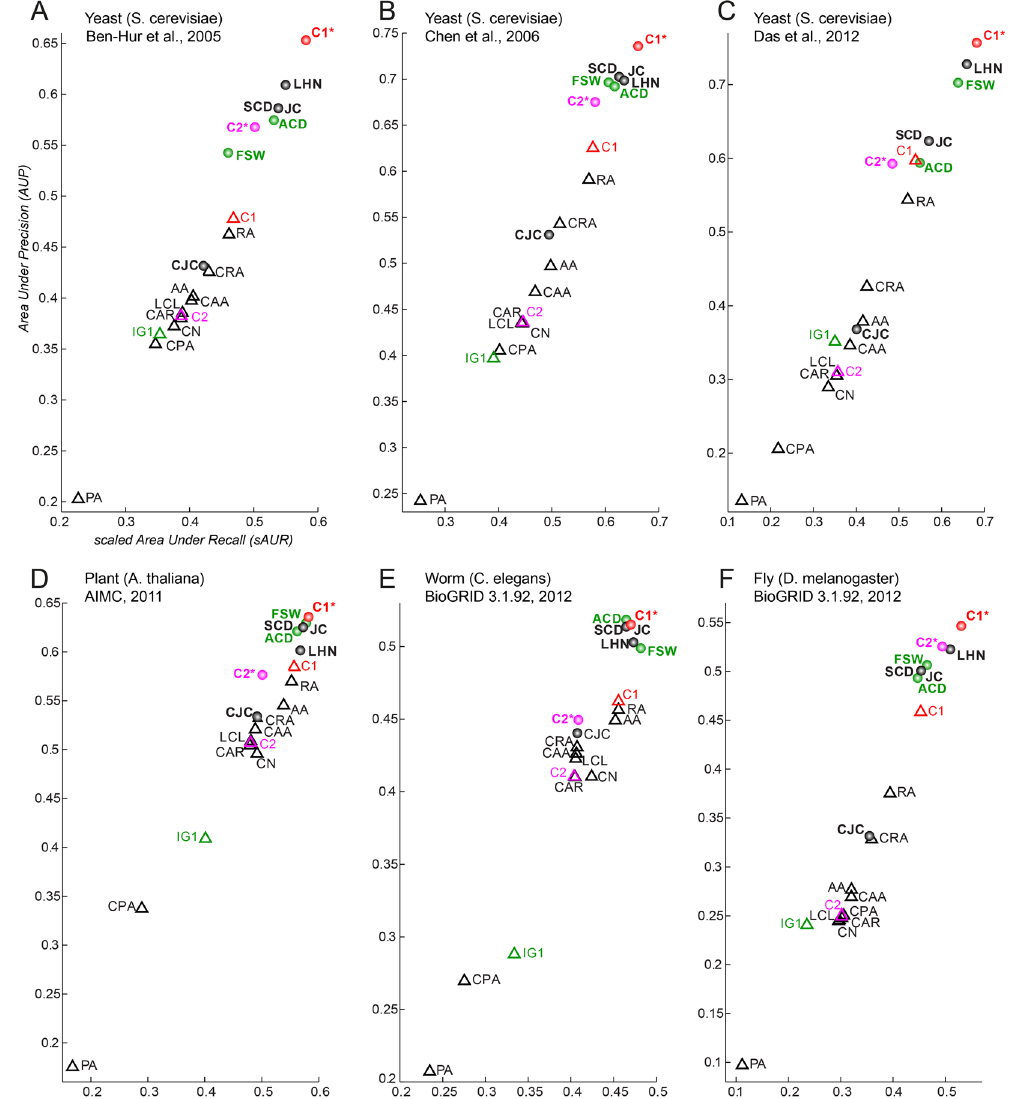
Figure 3. Performance evaluation in network 1, 2, 3, 4, 5, 6. Different colours are used to distinguish: the classical network science reliability models (black); the traditional network biology models (green); the two new local-community models based on the rule C1 and its normalized version C1 * (red); the two new local- community models based on the rule C2 and its normalized version C2 * (magenta). The triangle symbol is adopted to mark the non-normalised